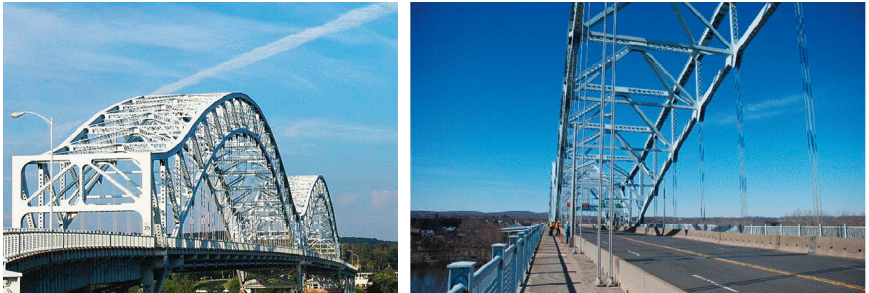
Figure 8: Arrigoni Bridge.